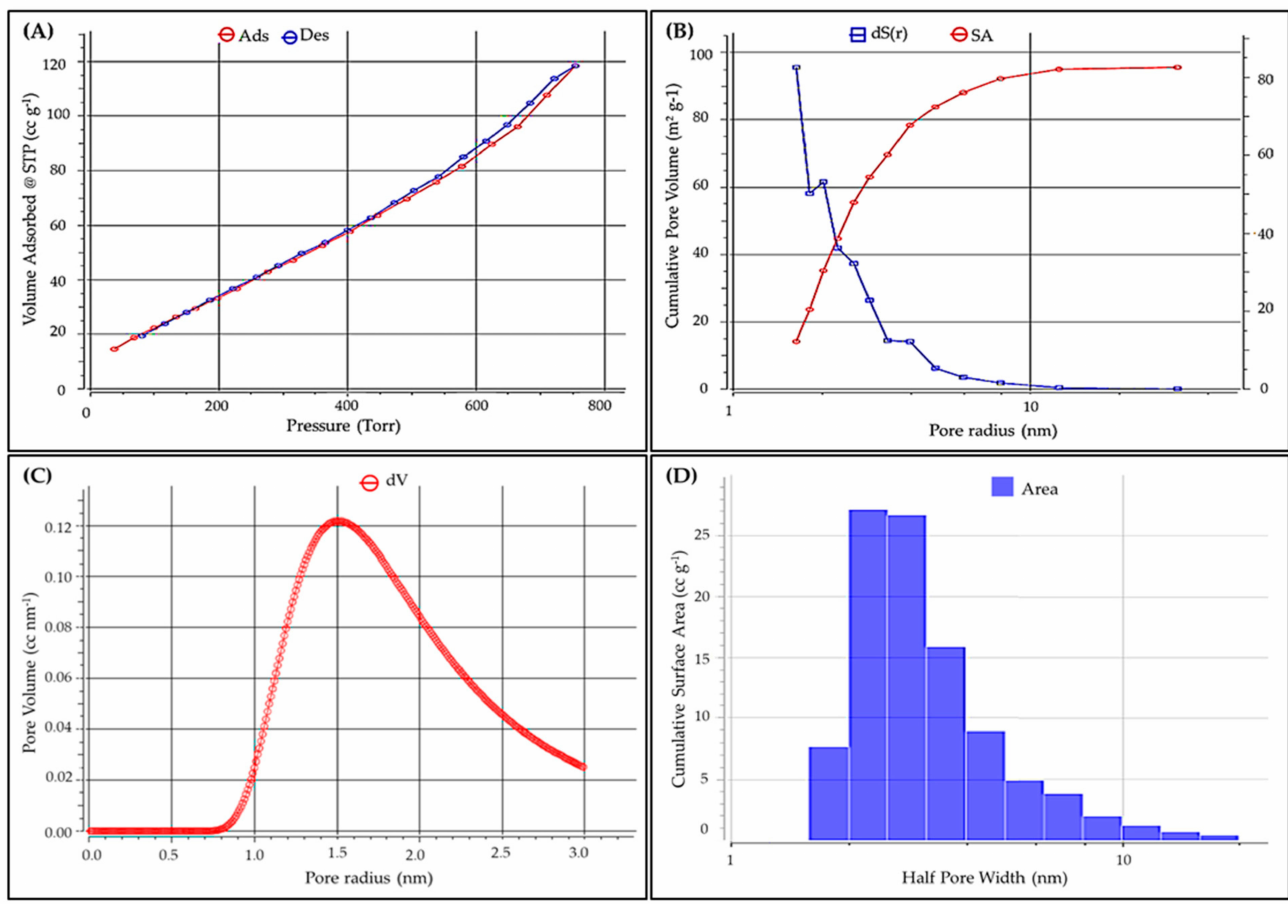
Figure 4. BET investigation of P. capillacea nanoparticle isotherm–adsorption–desorption ( A ), DH– desorption–dV(r) ( B ), DA method pore volume ( C ), and DFT method histogram surface area ( D